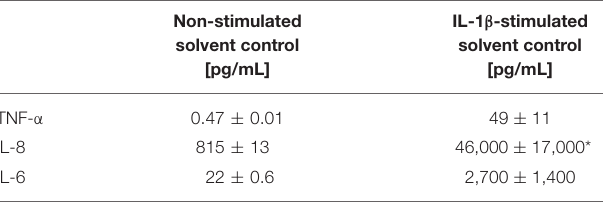
TABLE 1 | Absolute cytokine expression levels in pg/mL of TNF- α , IL-8, and IL-6 of HCEC-1CT measured in the supernatants of the non-stimulated and the IL-1 β -stimulated solvent control samples by a Magnetic Luminex ®